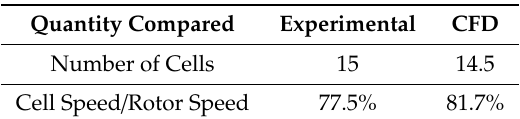
Table 3. The results of experimental and computational analysis of unsteady cells within the rim seal cavity. CFD refers to computational fluid